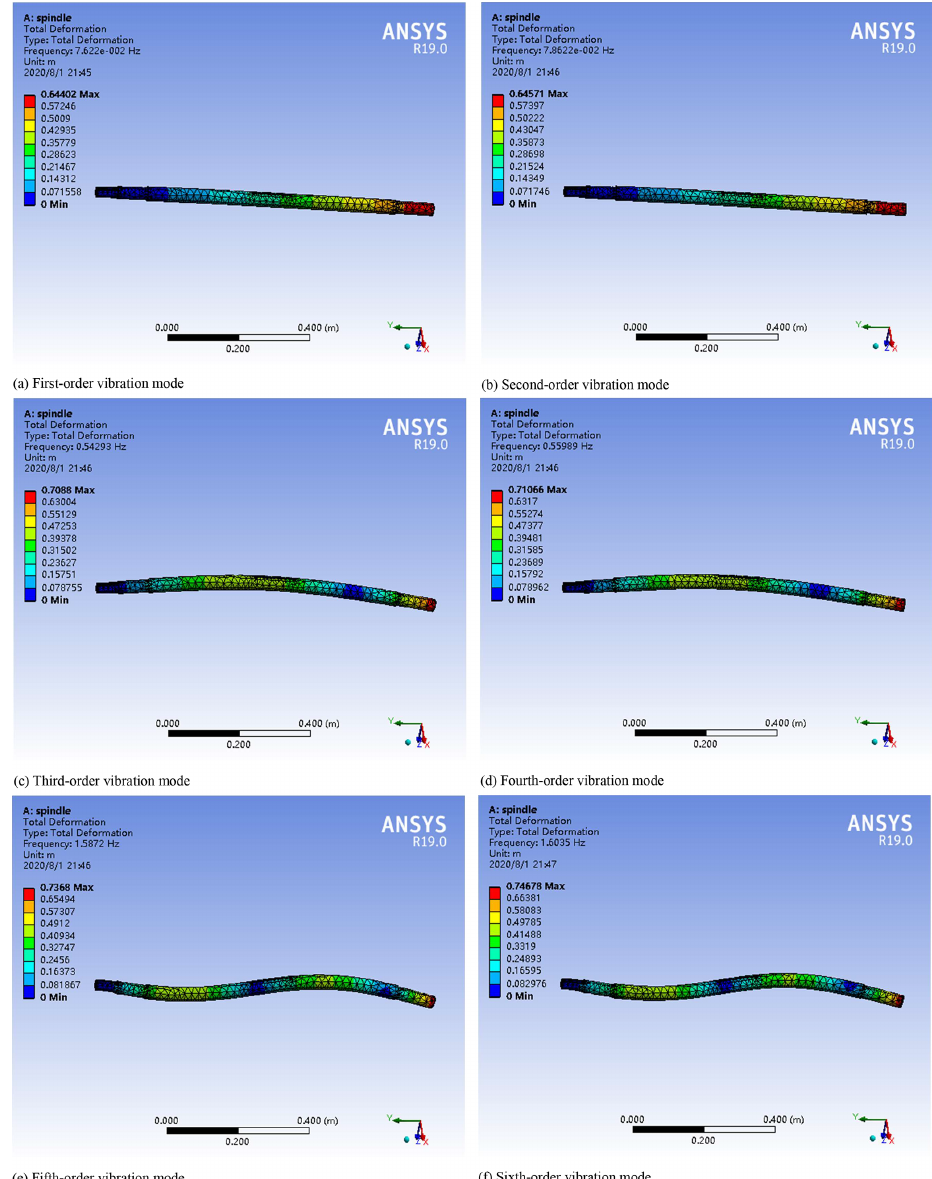
Figure 8. First sixth-order vibration modes of the spindle.